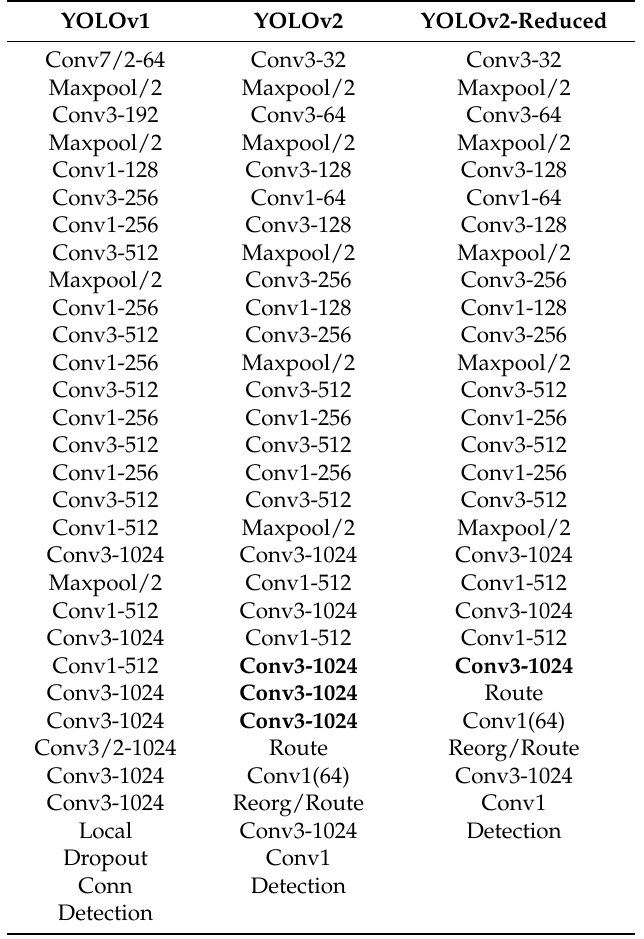
Table 8. The Network Architectures of YOLOv2 and YOLOv2-reduced.